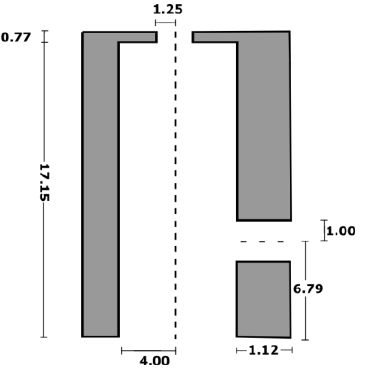
Figure 10. Schematic of the cross-section of the optimized resonator, dimensions in mm. The dashed lines represent the cylindrical symmetry axes.